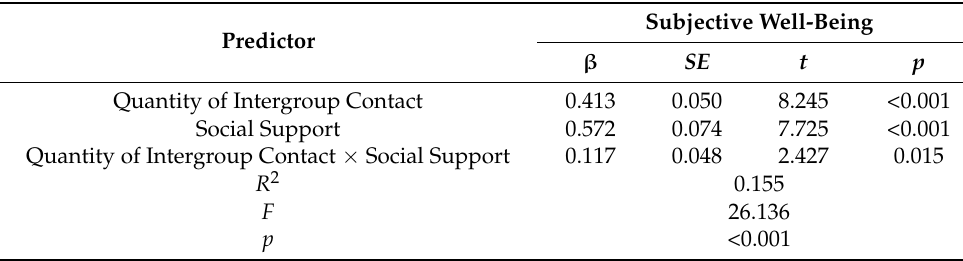
Table 3. Analysis of the moderating effect of perceived social support on quantity of intergroup contact and subjective well-being.